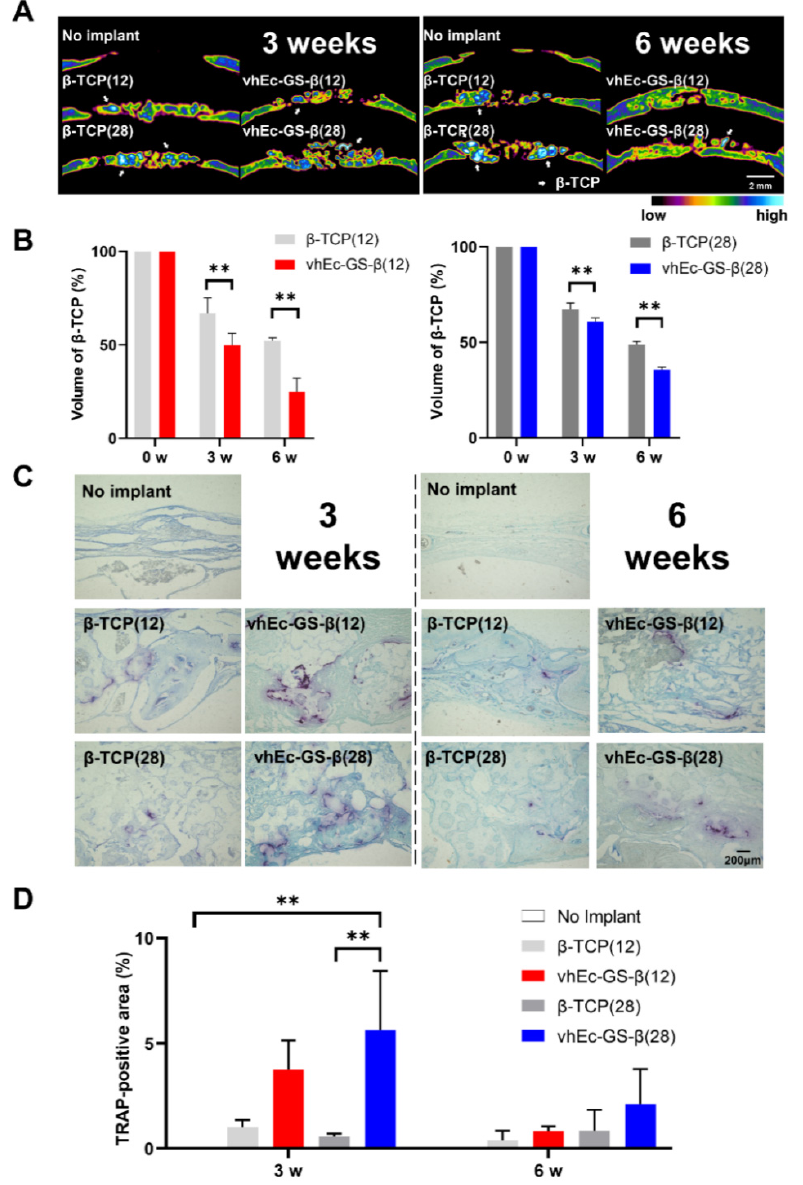
Figure 7. Degradation of β -tricalcium phosphate ( β -TCP) in bone defects. ( A ) Lateral view of bone defects at µ-CT analysis. Light and dark blue in bone defects represent residual β -TCP granules. ( B ) Quantification of residual β -TCP granules using µ-CT analysis. ( C ) Tartrate-resistant acid phosphatase (TRAP) staining for osteoclasts. ( D ) TRAP staining area in defects. ** p < 0.01.